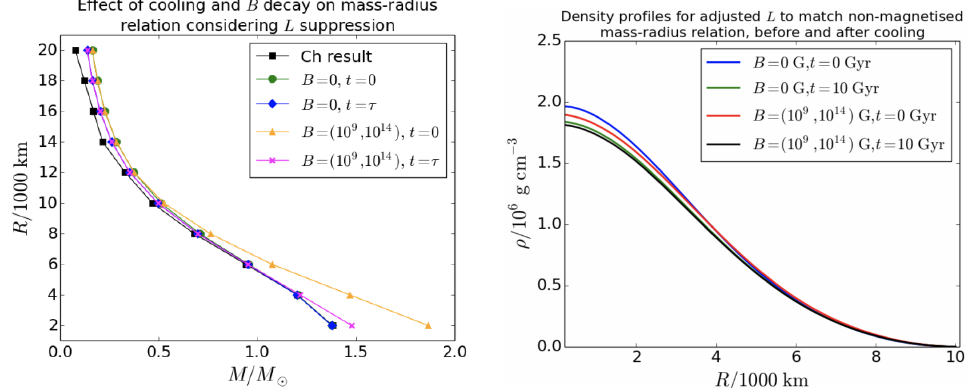
Figure 5. Left panel: Effect of magnetic field on L set to match the non-magnetised mass-radius relation. Results are shown for B = ( 0,0 ) at t = 0 (green circles), B = ( 0,0 ) at t = 10 Gyr (blue diamonds), B = ( 10 9 ,10 14 ) G at t = 0 (orange triangles) and B = ( 10 9 ,10 14 ) G at t = 10 Gyr (magenta crosses). Right panel: The matter density profiles for the same cases are shown for R = 10,000 km. See